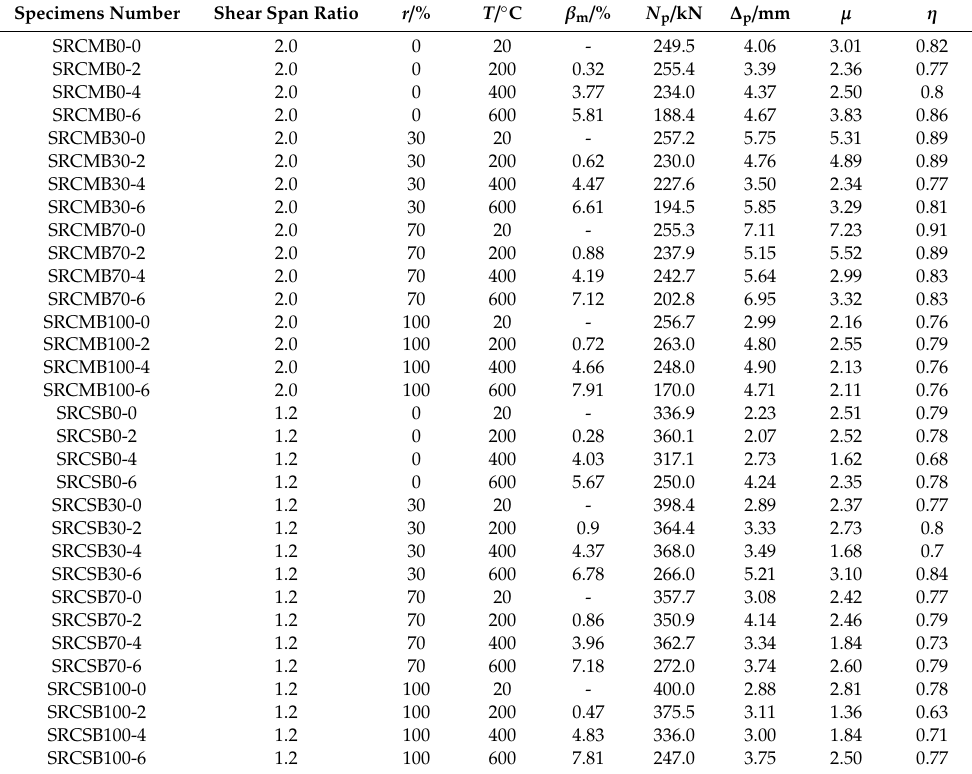
Table 5. Design parameters and experimental results of SRRAC beams.